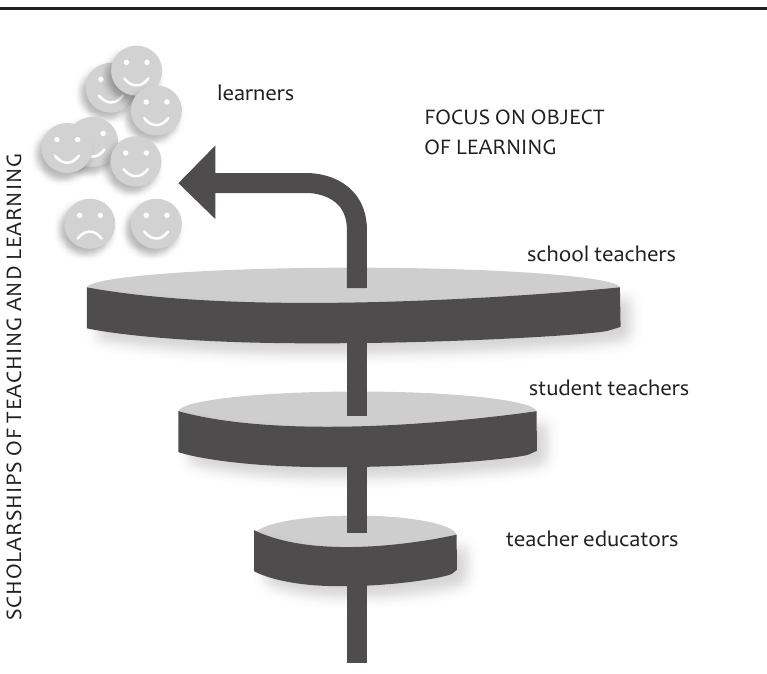
Figure 1. The three levels of the proposed approach, with the object of learning as focus and the scholarship of teaching and learning as sustaining function Theory and practice bridged for professional